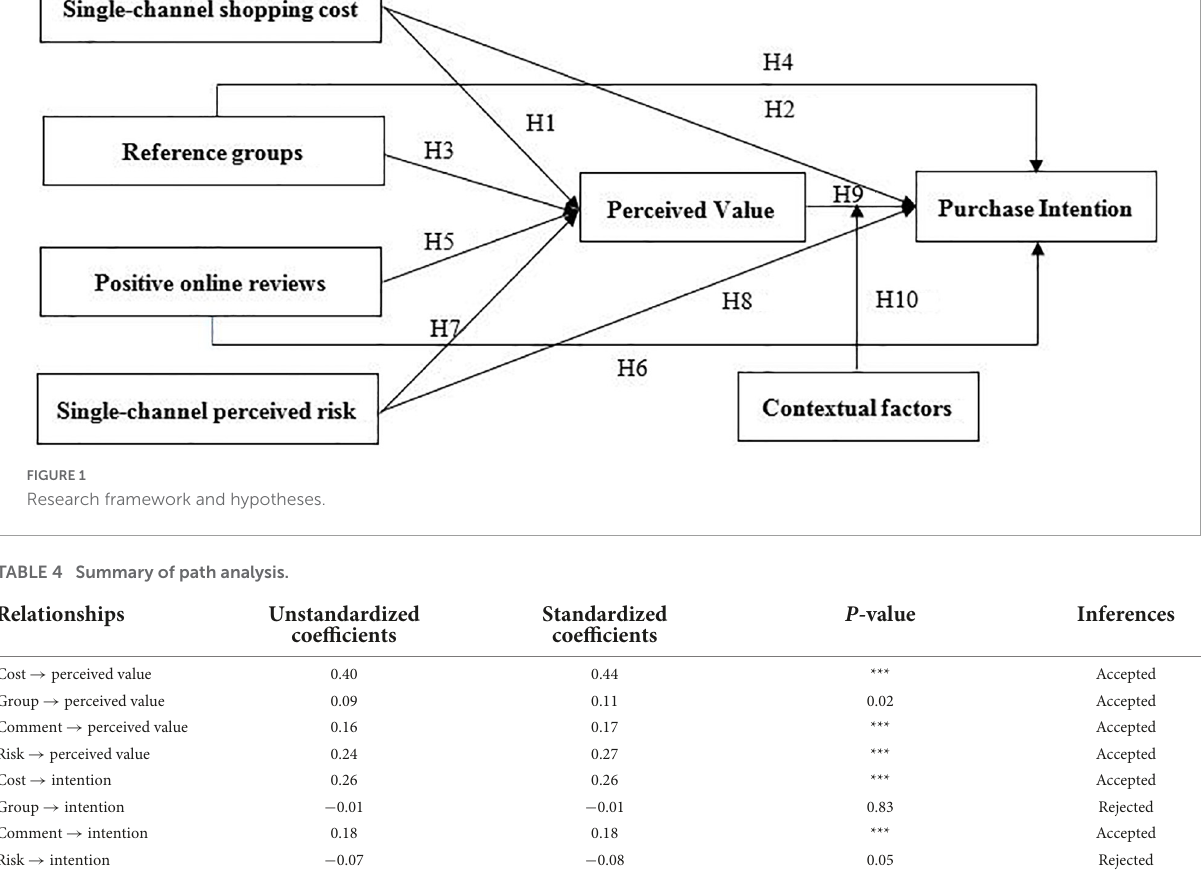
Table 5 , the direct effects of single-channel shopping